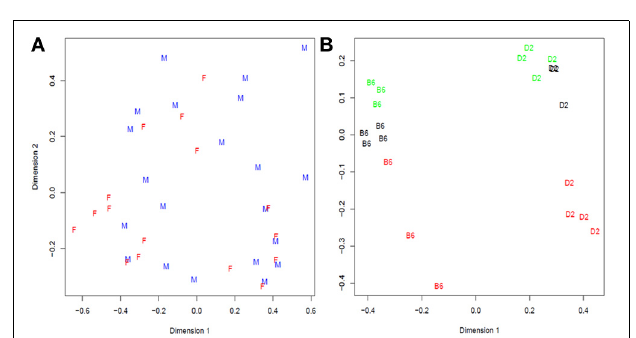
FIGURE 2 | Algorithm used to generate plasmode datasets with no differentially expressed transcripts under a model with one classification variable.